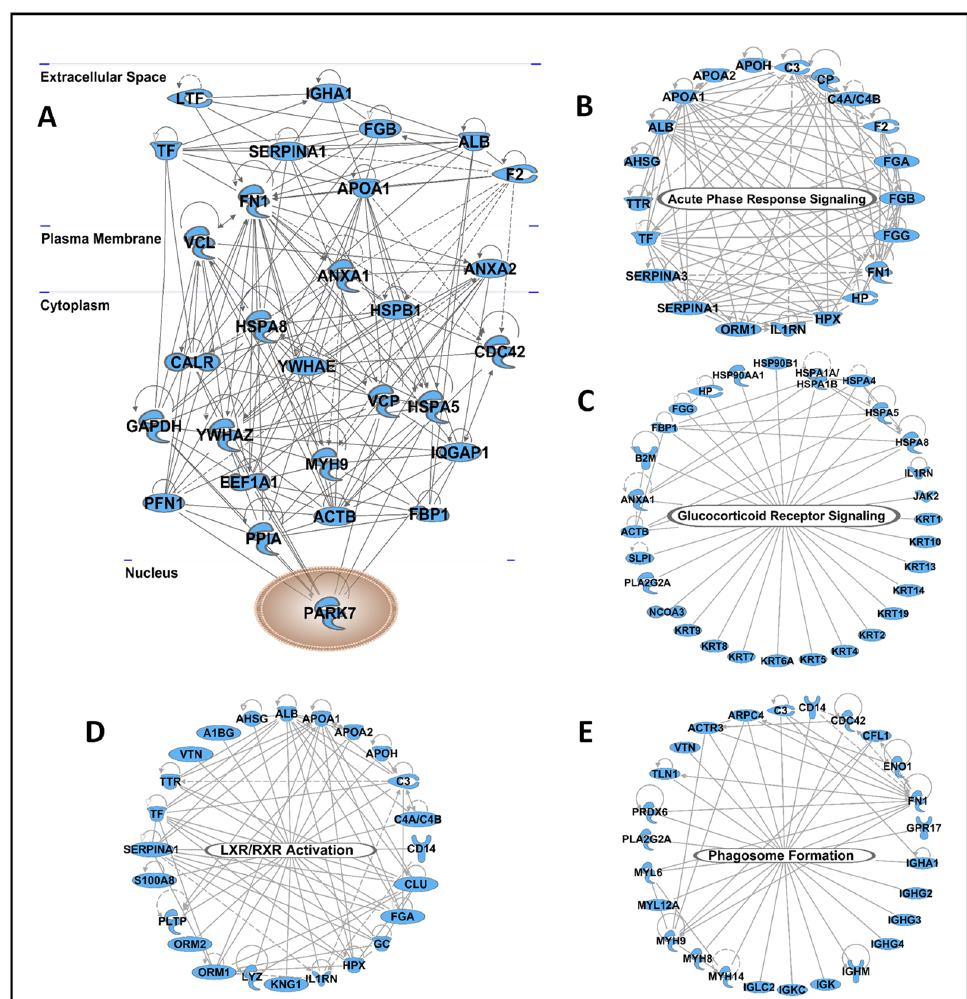
Figure 4. Network analyses revealed tear proteins with the highest level of interactions and four canonical pathways enriched in tear proteins. All 329 proteins detected in at least 50% of the samples were analyzed using Ingenuity Pathway Analysis software. ( A ) Proteins that showed the highest level of protein–protein interactions are depicted by cellular location. A total of four canonical pathways were highly enriched in tear proteins, including acute phase response signaling ( B ), glucocorticoid receptor signaling ( C ), LXR/RXR signaling ( D ), and phagosome formation ( E ).